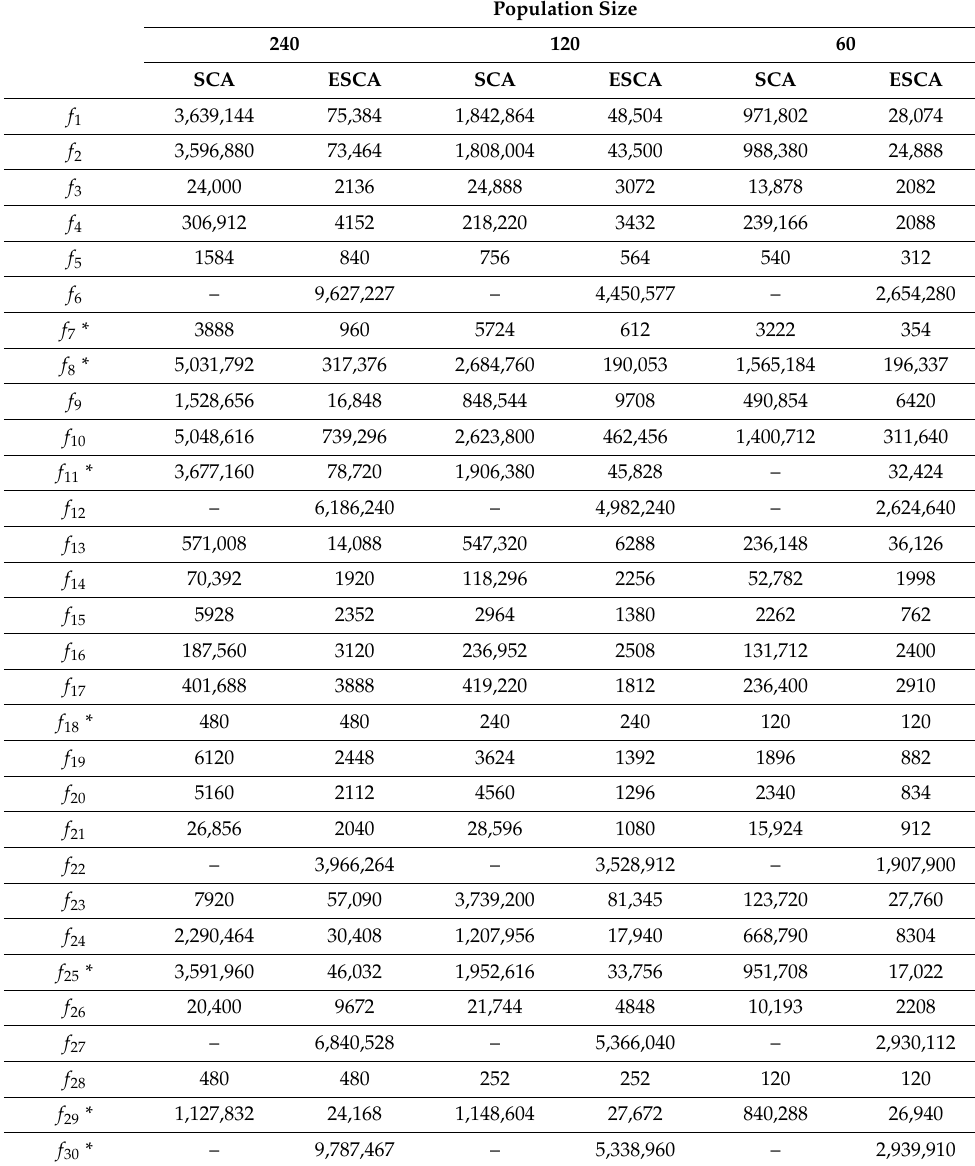
Table 4. Number of function evaluations for an error < 1 × 10 − 3 (* < 1 × 10 2 ).